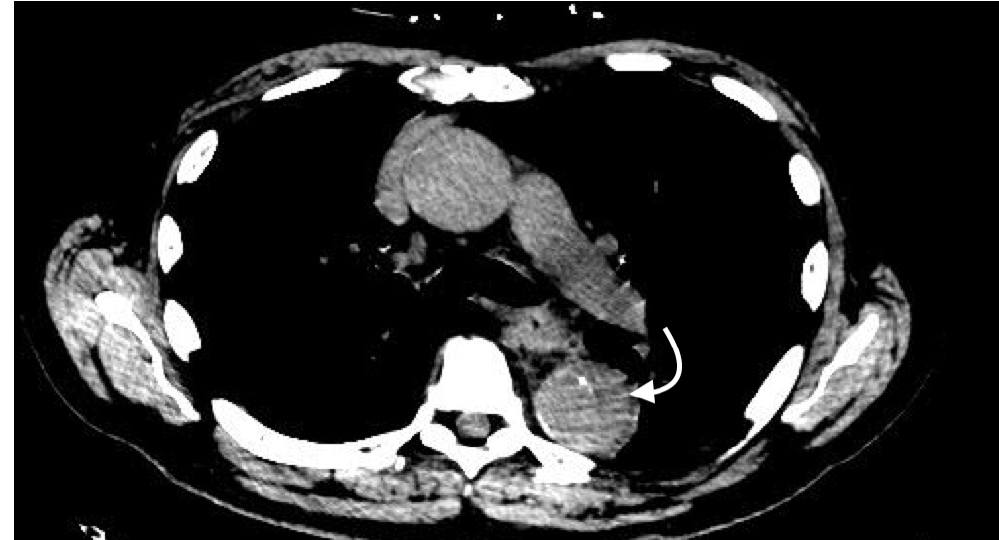
Figure 8. Axial non-contrast image demonstrating intramural hematoma (curved arrow) in the descending thoracic aorta. Note that the crescent-shaped intramural hematoma has higher attenuation than the thin portions of normal arterial wall surrounding it.